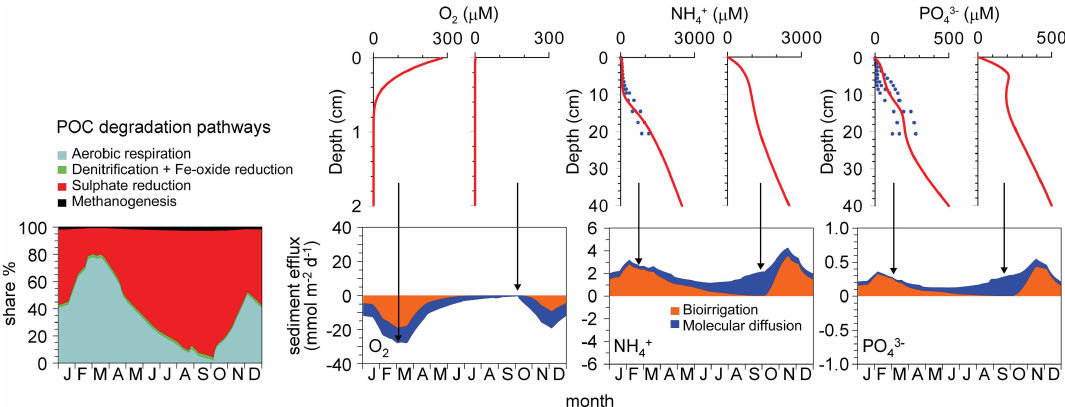
Fig. 25. Left-hand panel: model results showing the daily fraction of organic carbon mineralized by each degradation pathway at Boknis Eck (southwest Baltic Sea). Upper right-hand panels: representative depth concentration profiles of O 2 , NH + bioirrigation) and during hypoxia (low/zero bioirrigation) with measured winter concentrations from Boknis Eck (blue symbols). Lower right-hand panels: solute fluxes across the sediment–water interface (mmolm − 2 d − 1 ) by molecular diffusion and bioirrigation (negative values represent fluxes from the water column to the